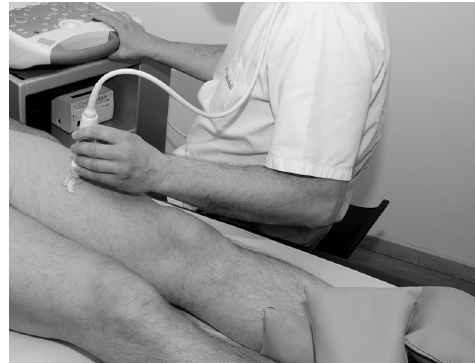
Figure 1. Ultrasound (US) scanning procedure with a participant lying supine and a US transducer placed on the anterior thigh.